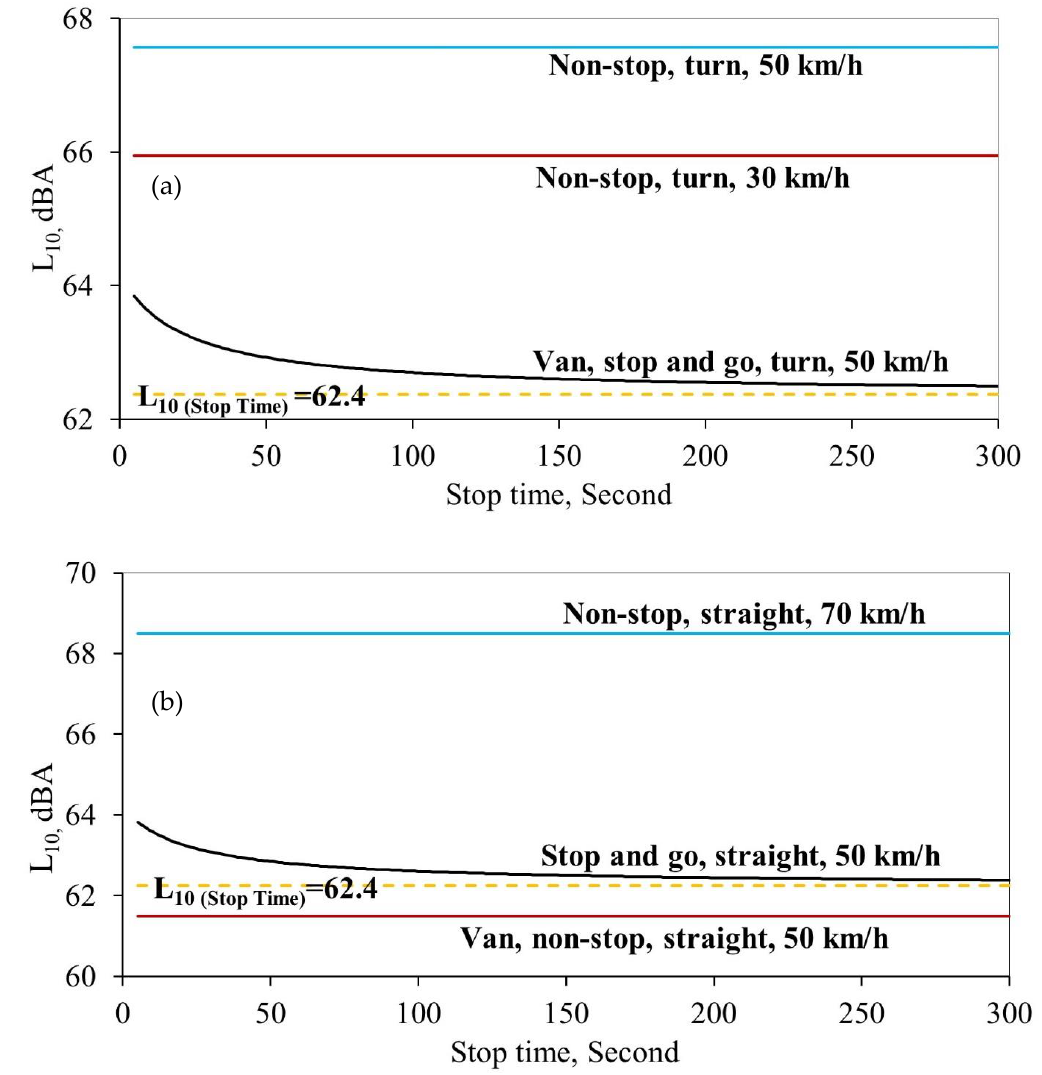
Figure 7. A comparison of average sound pressure levels ( L 10 ) against the stop durations. ( a ) Stop and go, turn; ( b ) Stop and go, straight.